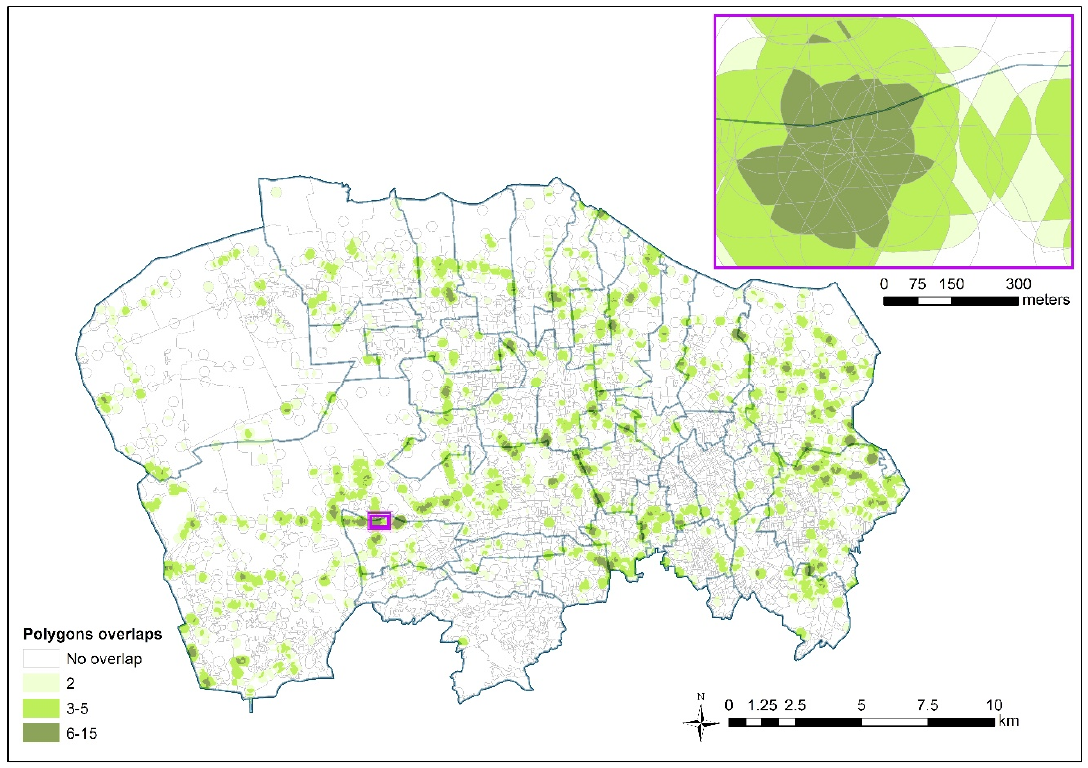
Figure 4. Overlaps of waste site impact areas after the union between the census-tracts layer and the break buffer overlaps-up layer. Detailed view in the purple frame.